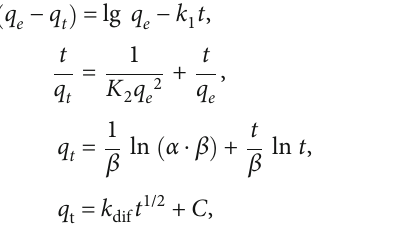
Figure 2: (a) First-order kinetics model, (b) second-order dynamic model, (c) Elovich model, and (d) intraparticle di ff usion model ( C mg · L -1 , V = 20 mL, temperature at 298